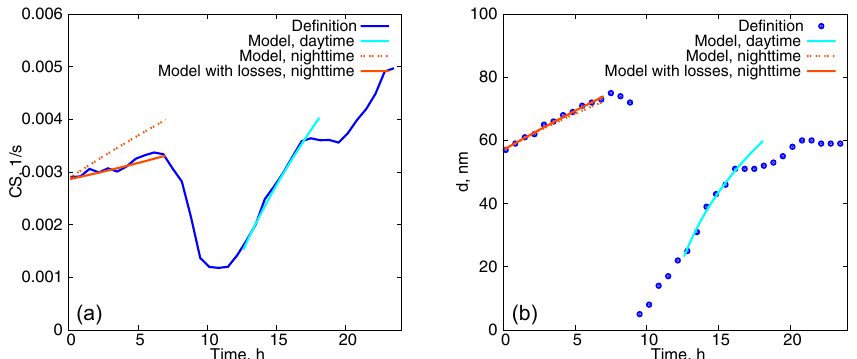
Figure 9. (a) Time evolution of the condensation sink. Blue curve: calculated from the definition, orange dashed curve: modelled with the constant particle number concentration, orange solid curve: modelled with the decreasing particle number concentration, cyan curve: modelled with the constant particle number concentration, daytime. (b) Characteristic diameter of the aerosol mode with a larger number concentration as a function of